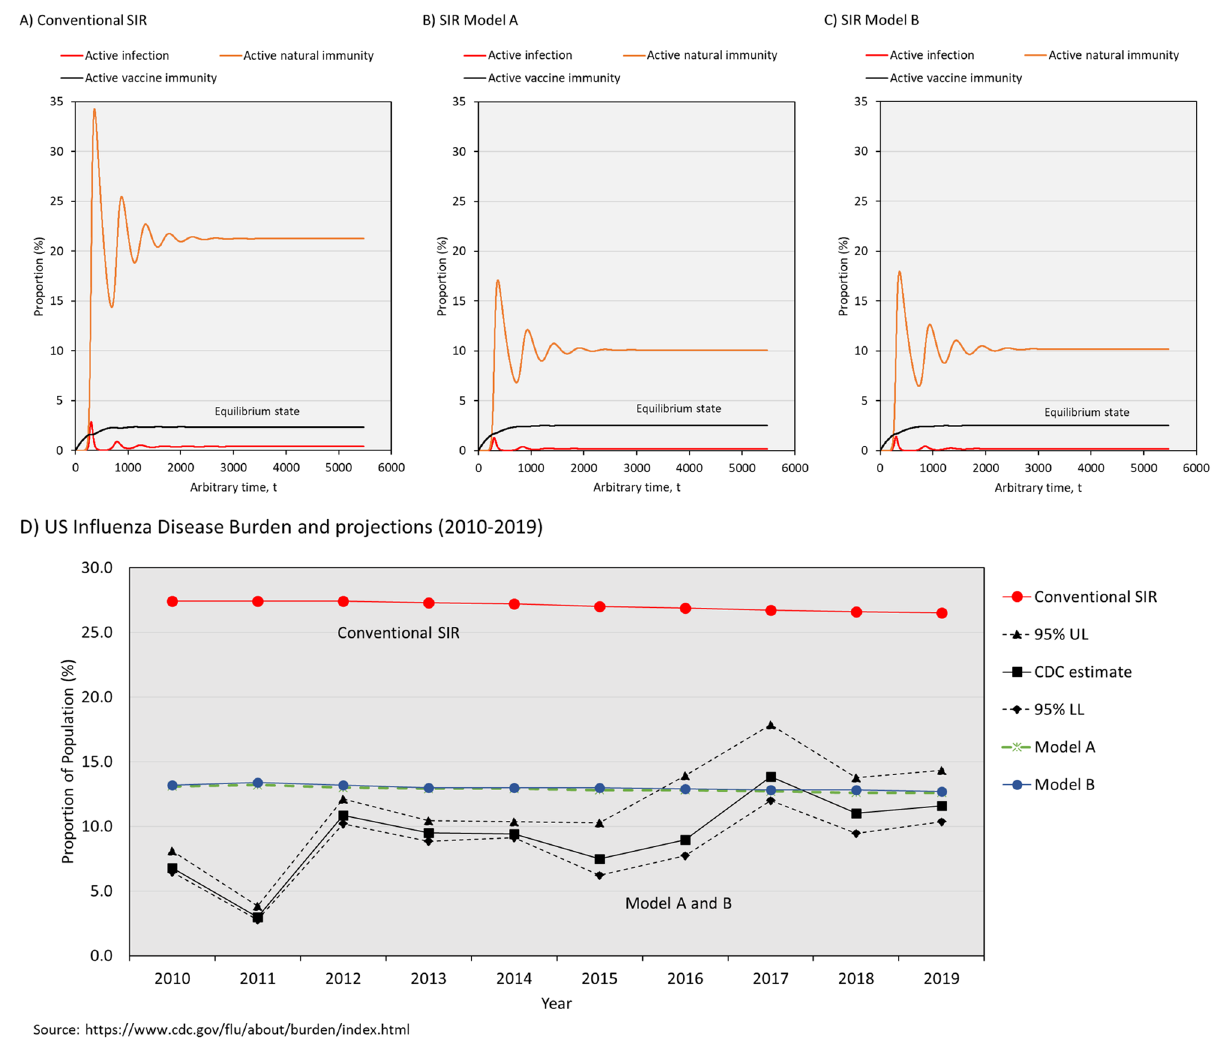
Figure 6. The projected disease burden of seasonal influenza in the United States from 2010 to 2019. Transmission dynamics of seasonal influenza projected by (A) conventional SIR model, (B) Model A, and (C) Model B. (D) Comparison of projected disease burden by the conventional SIR model, Model A and Model B with estimates reported by the CDC from 2010 to 2019. Model A and B provided more accurate projections than the conventional SIR model. All data used to create the figures can be sourced at https:// github. com/ willi am81/ newSIR. herd- immun ity. model.